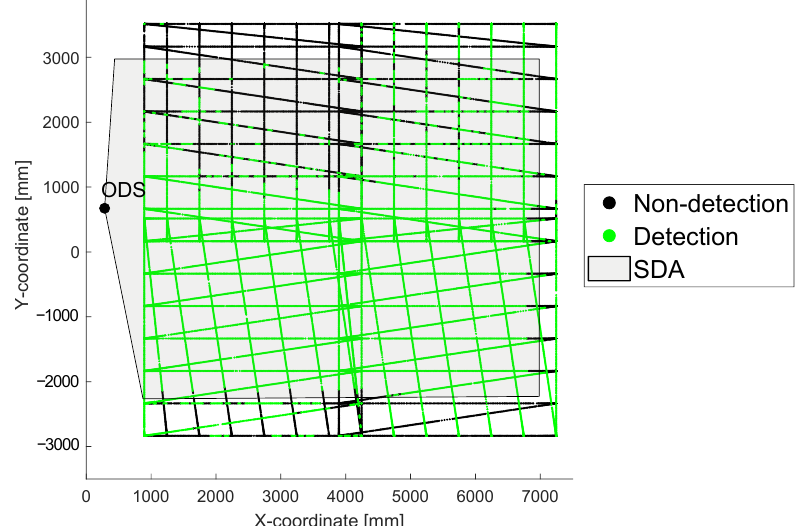
Figure 5. A point cloud resulting from test example with a 2D LiDAR sensor on the test stand and the example environment are shown in this